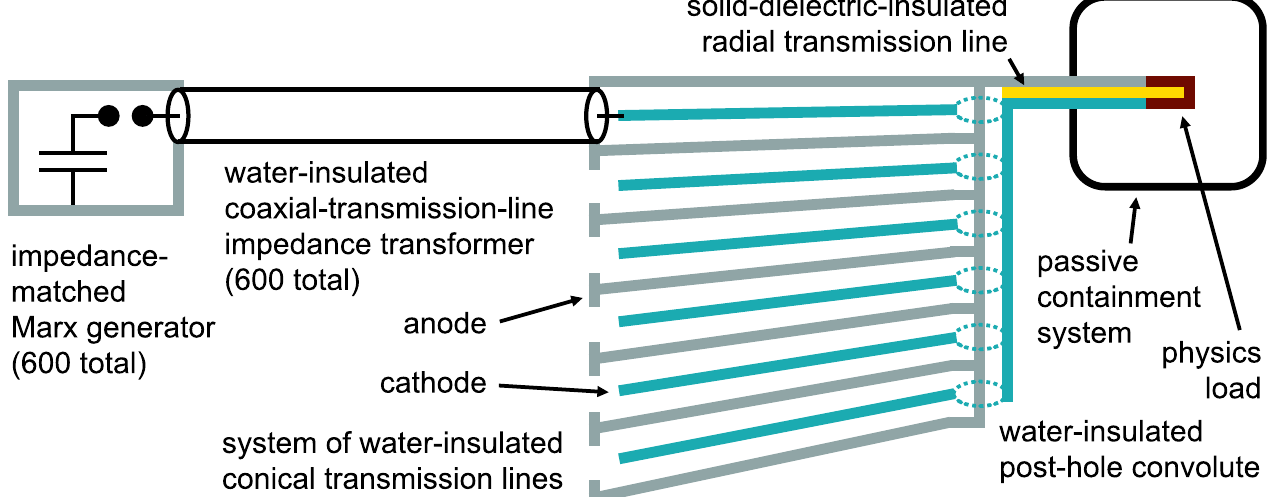
FIG. 2. Conceptual design of Neptune. Since the design includes no MITLs, it has negligible current loss and enables use (on shots conducted with a hazardous material) of a passive containment system, one that is always